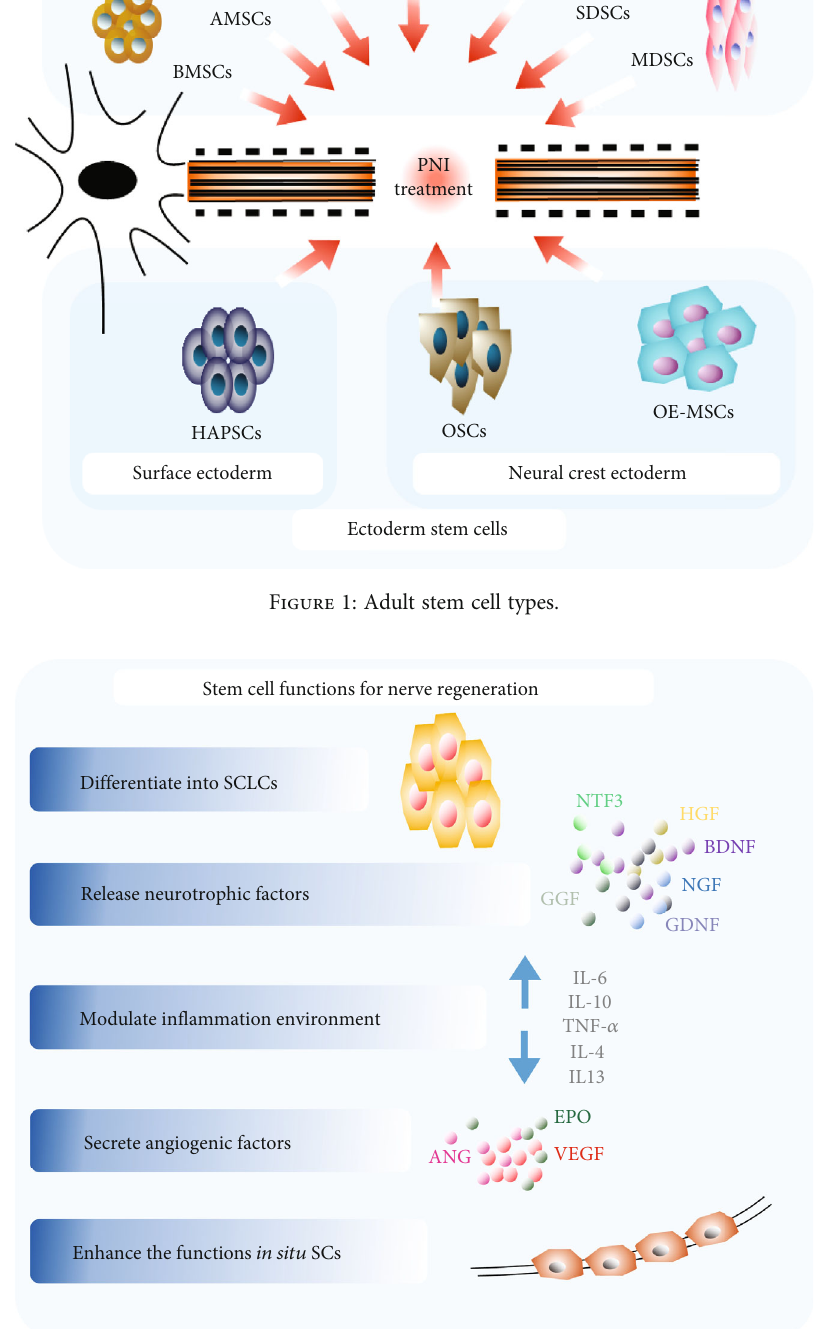
Figure 2: Functions of adult stem